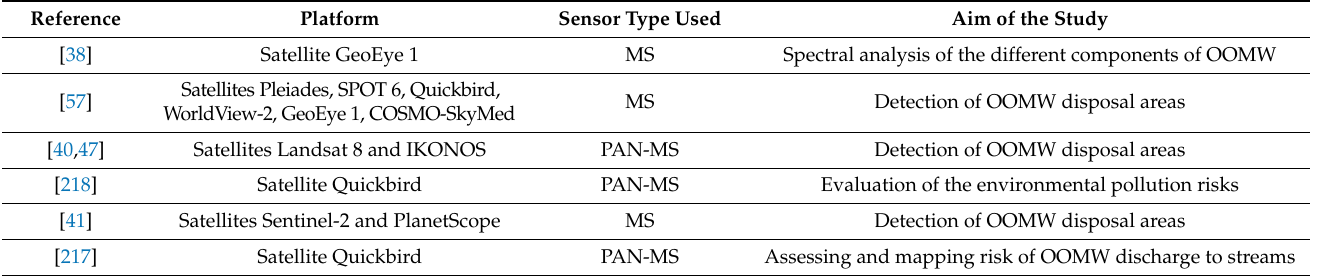
Table 5. References dealing with the olive oil mill wastes (OOMW)